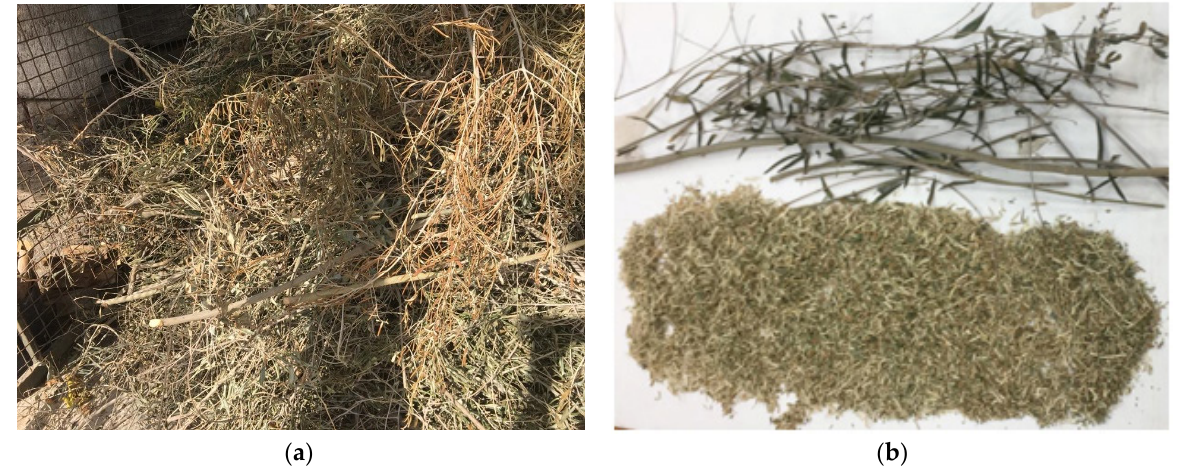
Figure 1. ( a ) Olive tree pruning waste; ( b ) leaves from a branch.